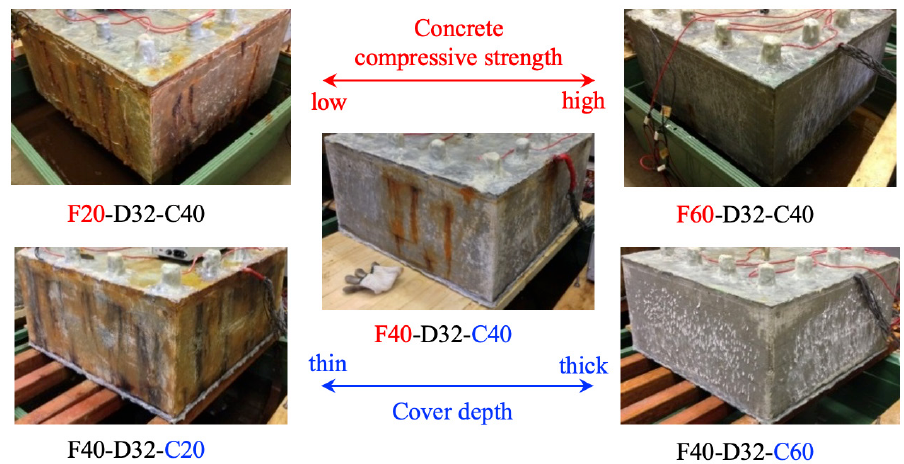
8 of 14 Figure 6. Corrosion rate of steel rebar according to concrete cover depth. 3.3. Development of Corrosion-Induced Concrete Cracking Figure 7 shows the state of the specimen surfaces according to concrete compressive strength and cover thickness after approximately one month of accelerated corrosion testing. The same amount of voltage (10 V) was applied to all specimens, but the current was varied for each specimen and each rebar. As such, Table 5 shows the average corrosion amounts for the longitudinal and transverse bars that were calibrated using the integrated current amount. Table 5. Average calibrated corrosion amount for steel bar after 30 days of accelerated corrosion testing.